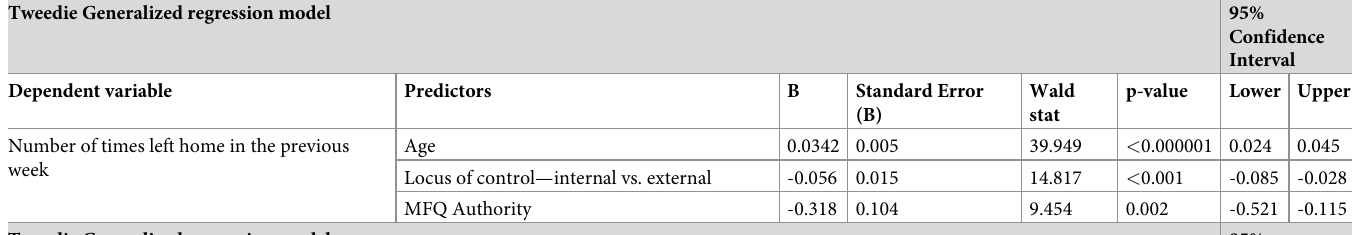
Table 7. Generalized regression